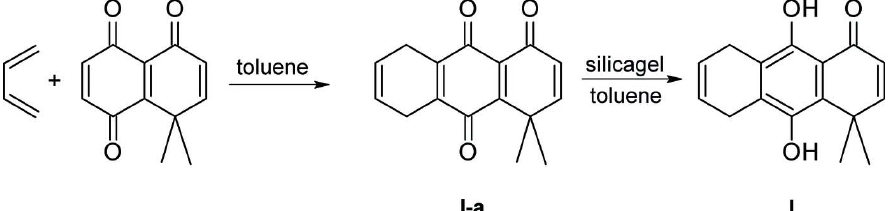
The formation of the title